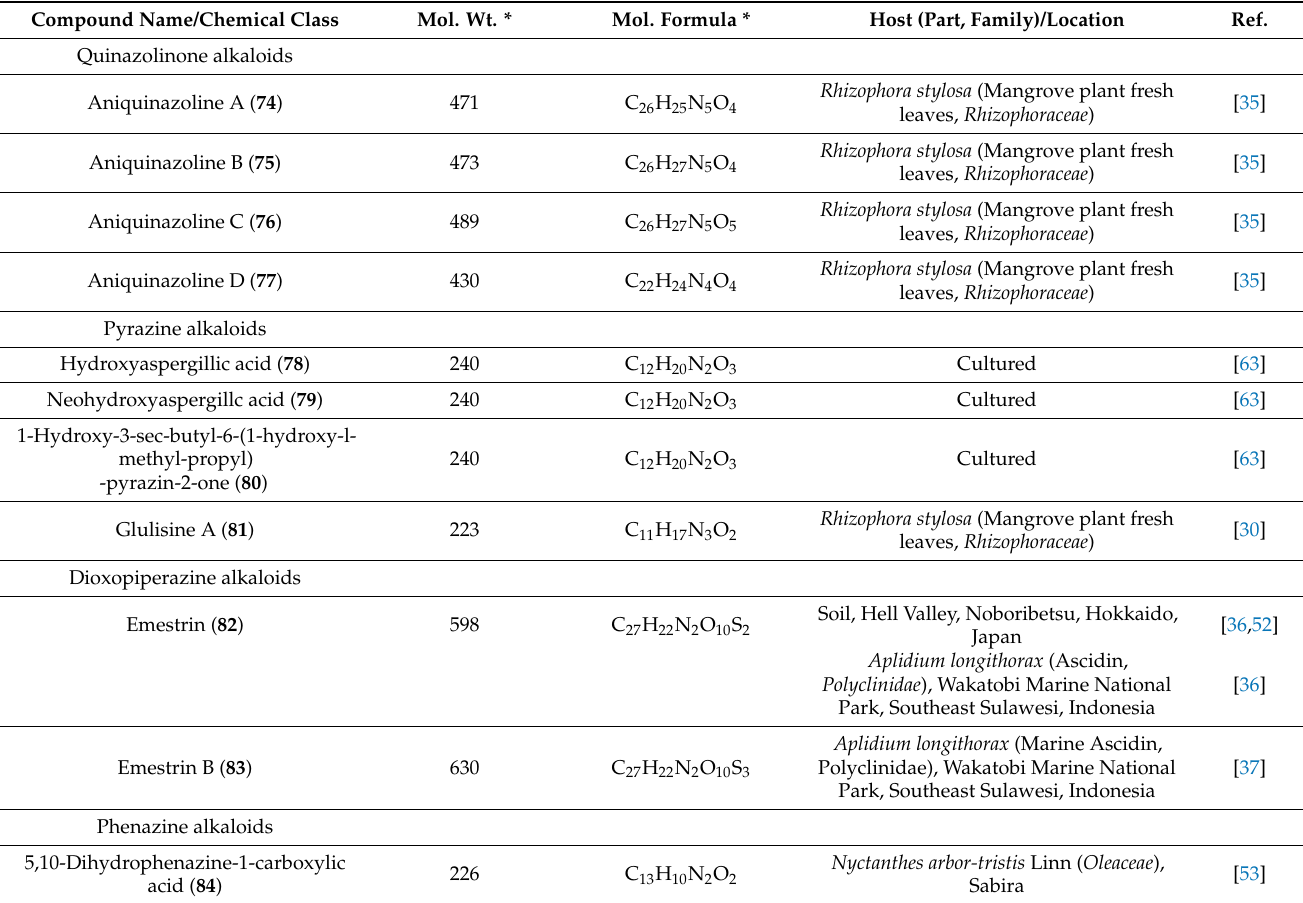
Table 6. Quinazolinone, pyrazine, dioxopiperazine, and phenazine alkaloids reported from A. nidulans